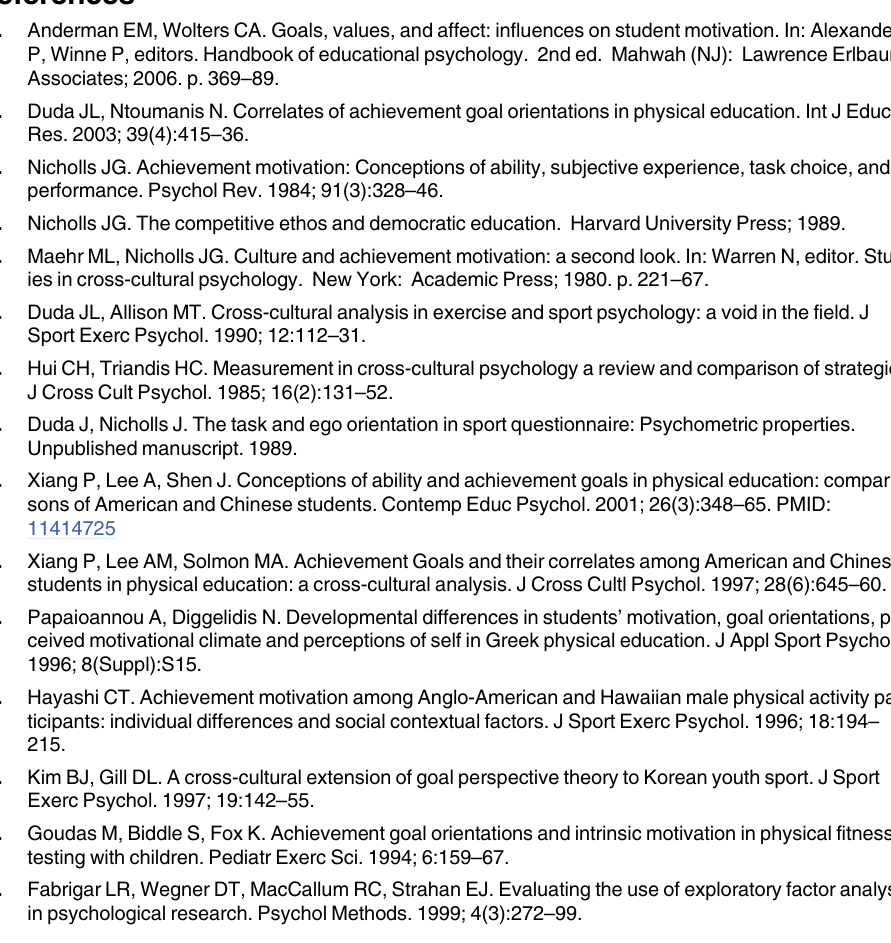
S1 Fig. Factor structure and completely standardized factor loading on goal orientation in the American sample. S2 Fig. Factor structure and completely standardized factor loading on goal orientation in the Chinese sample. S1 Table. Descriptive statistics, internal consistency for American and Chinese samples. (TIF) S2 Table. Summary of Goodness of Fit for dispositional goals.